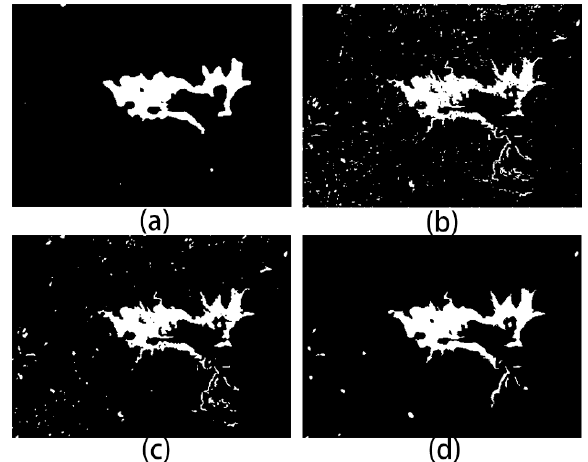
Figure 15. Sardinia Island dataset: CDMs obtained by: ( a ) CD_PCA_Kmeans [1]; ( b ) CD_MLS [2]; ( c ) Semi_FCM method [3]; and ( d ) the proposed framework.